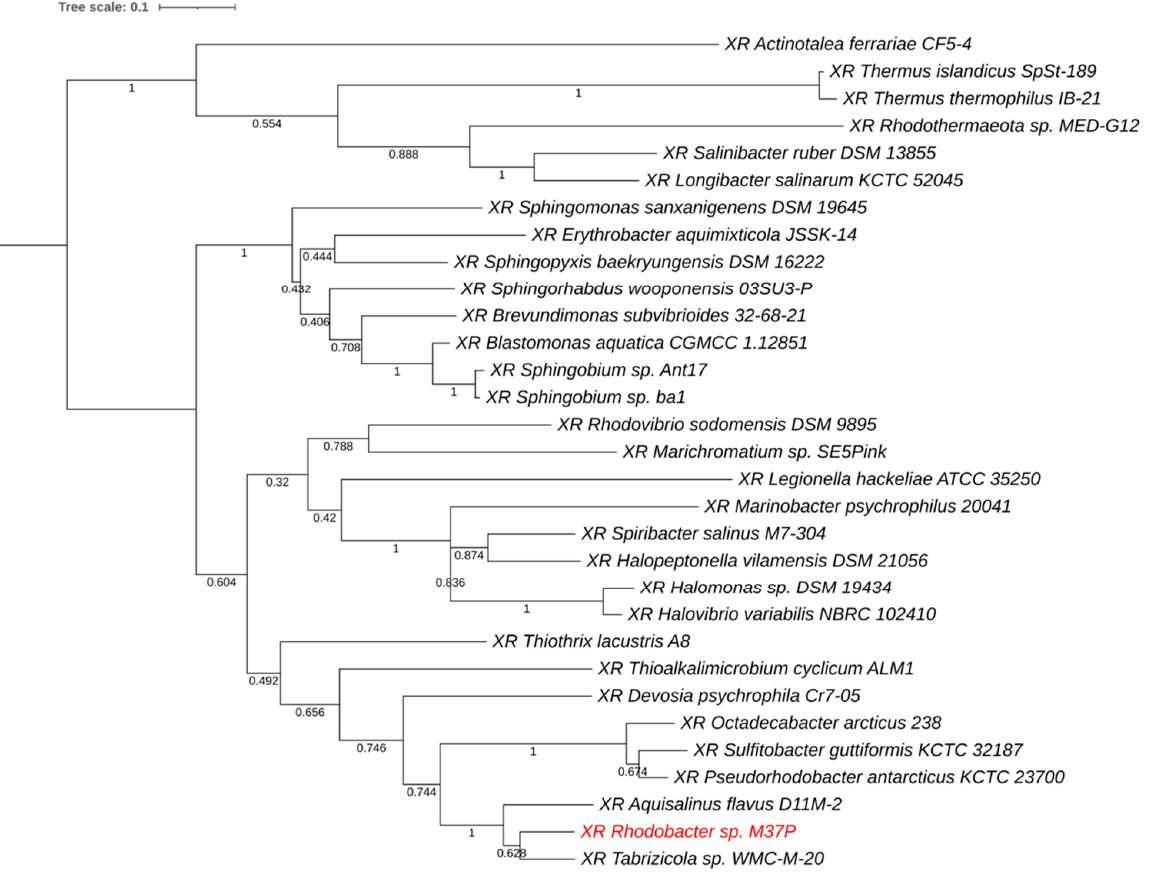
Figure 5. Phylogenetic comparison of xanthorhodopsin from Rba. sp. M37P to its closest xanthorhodopsin homologs derived from genome sequences. The M37P XR protein (in red) forms a separate clade with closely related XRs from Aquisalinus flavus D11M ‐ 2 and Tabrizicola sp. WMC ‐ M ‐ 20. The xanthorhodopsin gene in strain M37P is followed by several carotenoid biosyn ‐ thesis genes (polyprenyl synthetase; phytoene desaturase (neurosporene ‐ forming) (EC 1.3.99.28); phytoene synthase (EC 2.5.1.32); lycopene beta ‐ cyclase (EC 5.5.1.19); and 15,15 ′‐